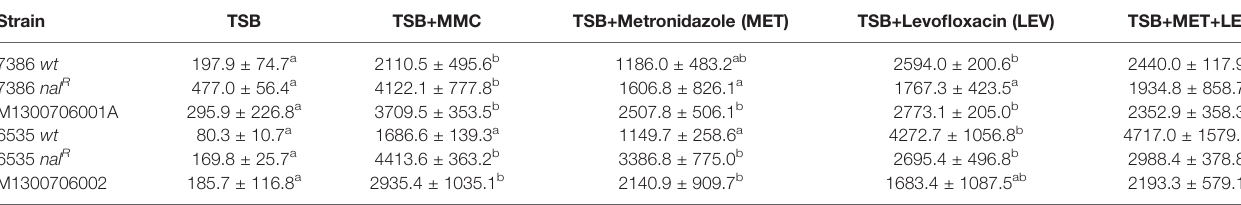
TABLE 3 | Stx2a production of the different